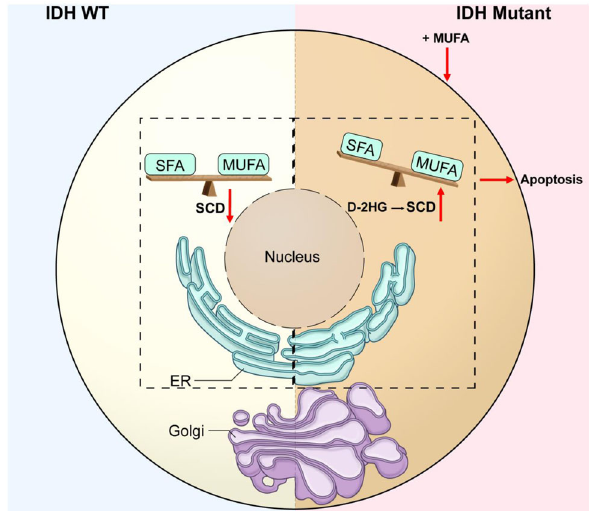
Fig. 7 Proposed model for IDH1 mut -induced phospholipid imbalance and cellular function. IDH1 WT cells display homeostatic levels of phospholipids and basal expression of hSCD enzymes. IDH1 mut cells induce high levels of hSCD enzymes, which alter the phospholipid balance and the morphology of ER and Golgi. Shown with red arrows is a potential way to exploit this alteration, by addition of oleic acid a prevalent MUFA, which leads to apoptosis. Dashed rectangle signi fi es the fact that hSCD enzymes are localized within the ER